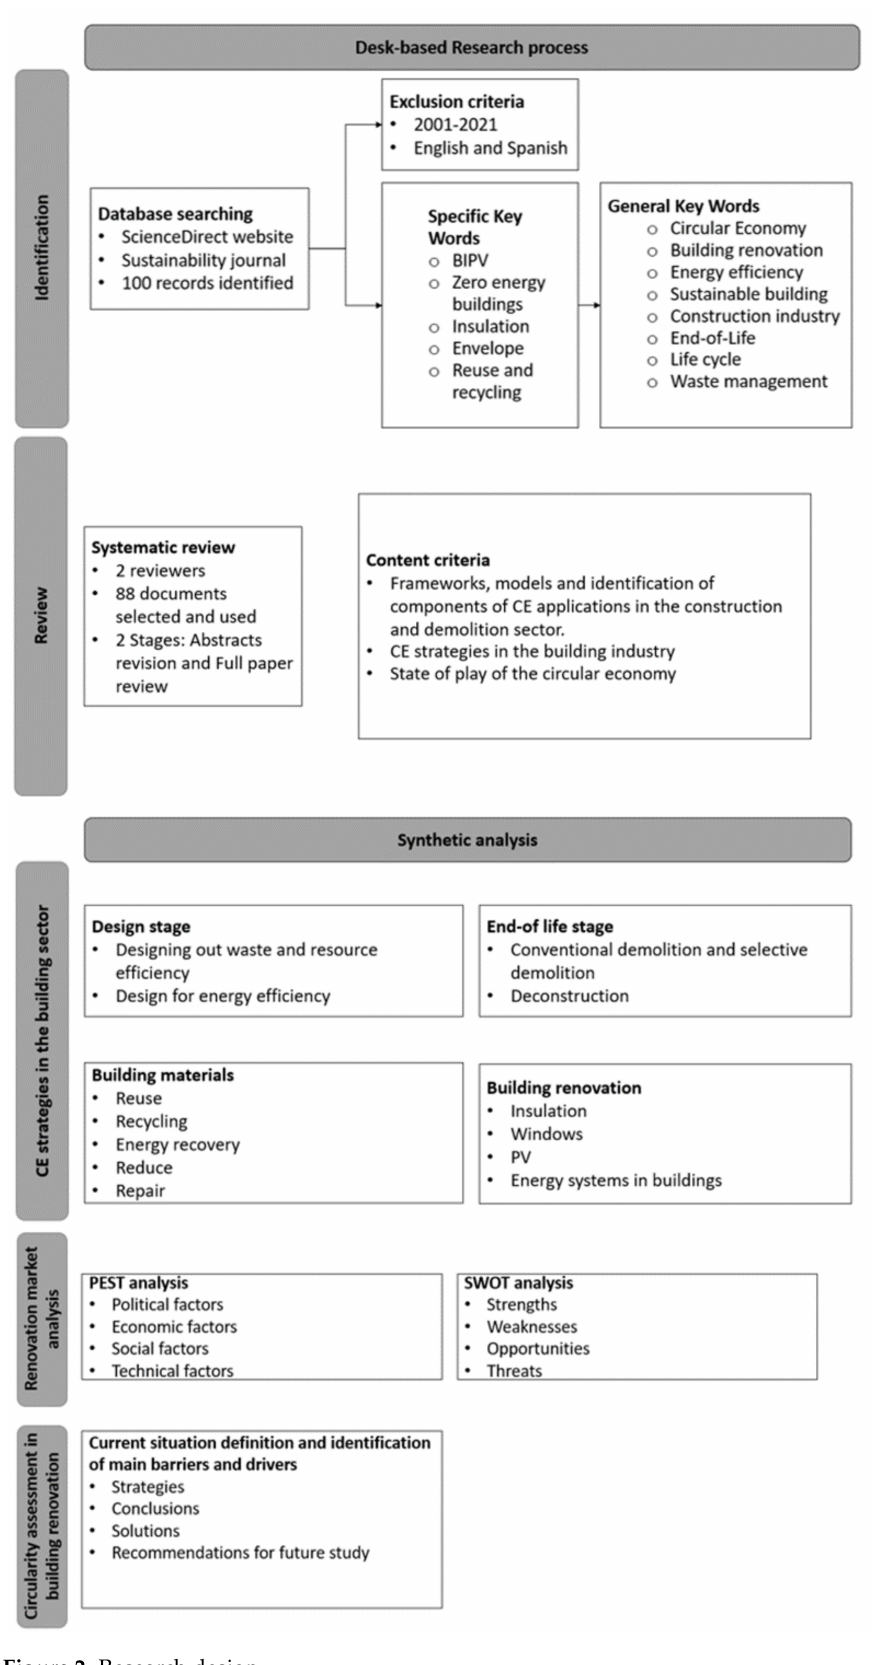
Figure 2. Research